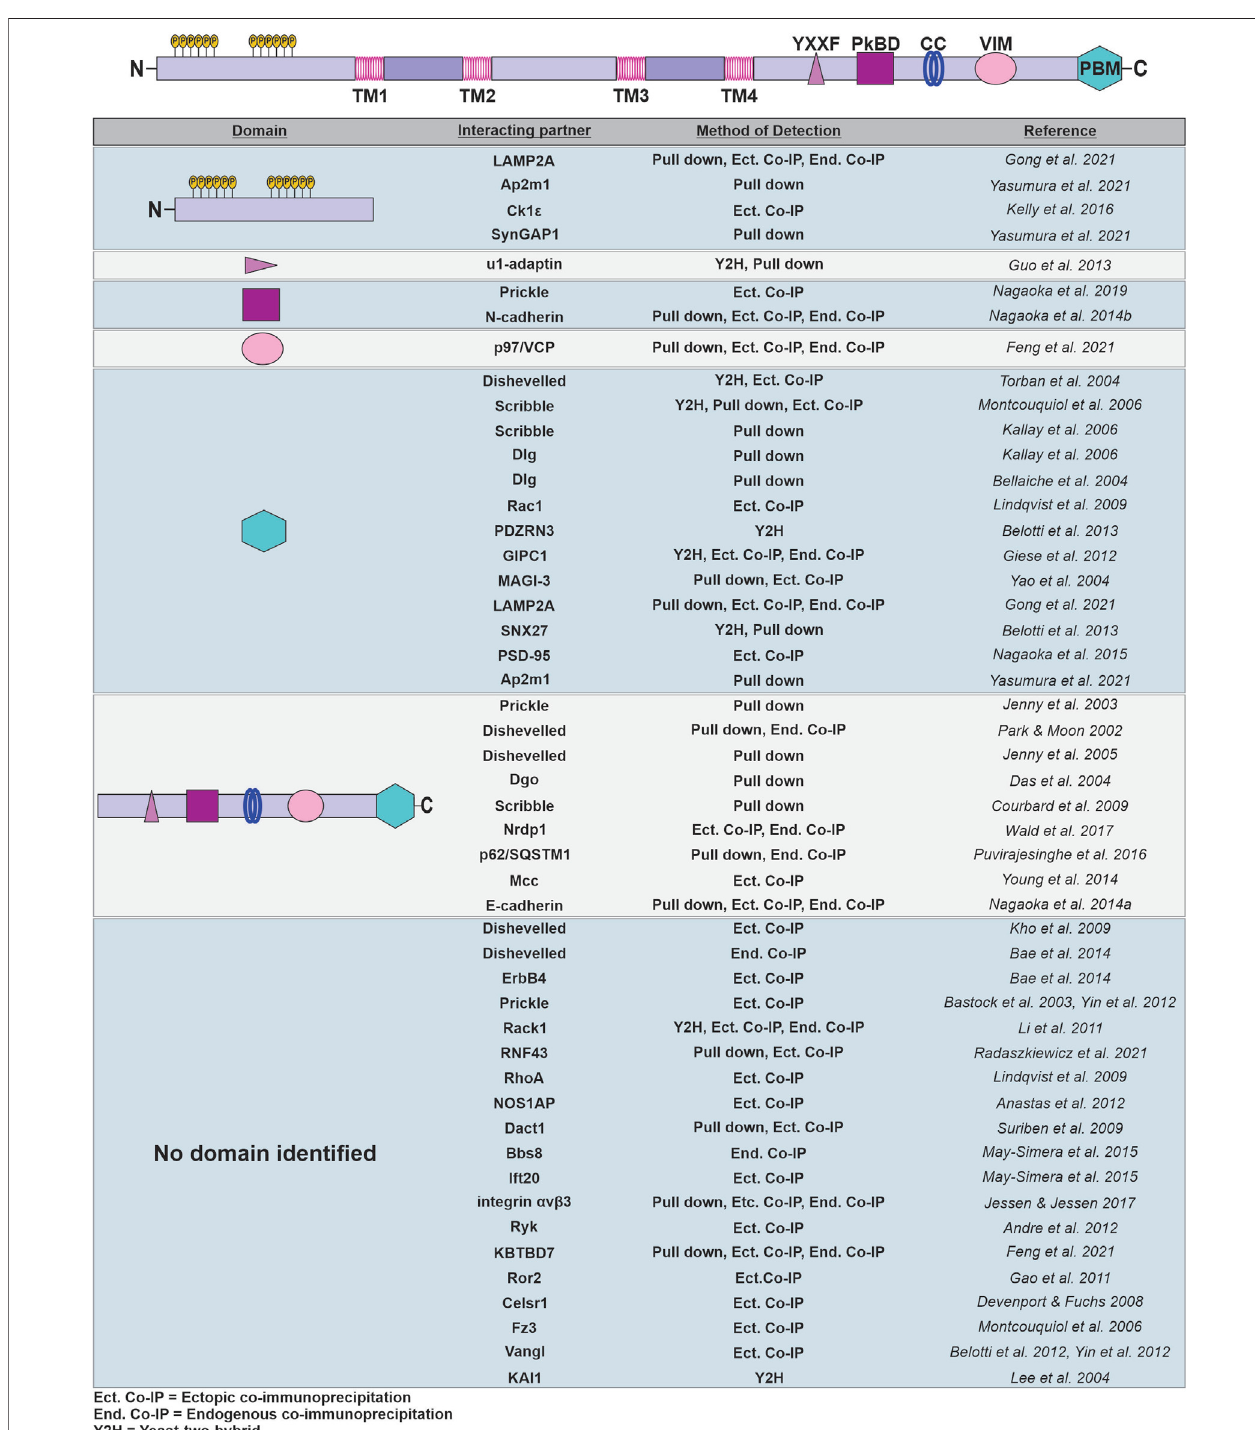
FIGURE 2 | Structure and known binding partners of Vangl. Vangl is a four-pass transmembrane protein with intracellular N- and C-terminal tails. The N-terminus contains serine-rich regions that are phosphorylated upon Wnt stimulation. The large C-terminal tail contains several domains including a plasma membrane-targeting motif (YXXF), a Prickle binding domain (PkBD), a predicted coiled-coil region (CC), a VCP interacting motif (VIM), and a PDZ binding motif (PBM). Vangl has numerous known interacting partners, many of which have been mapped to its speci fi c domains, or more generally to the N- or C-terminus. Binding interactions were assessed by pull down assays, yeast-two-hybrid screens, or ectopic or endogenous co-immunoprecipitations.